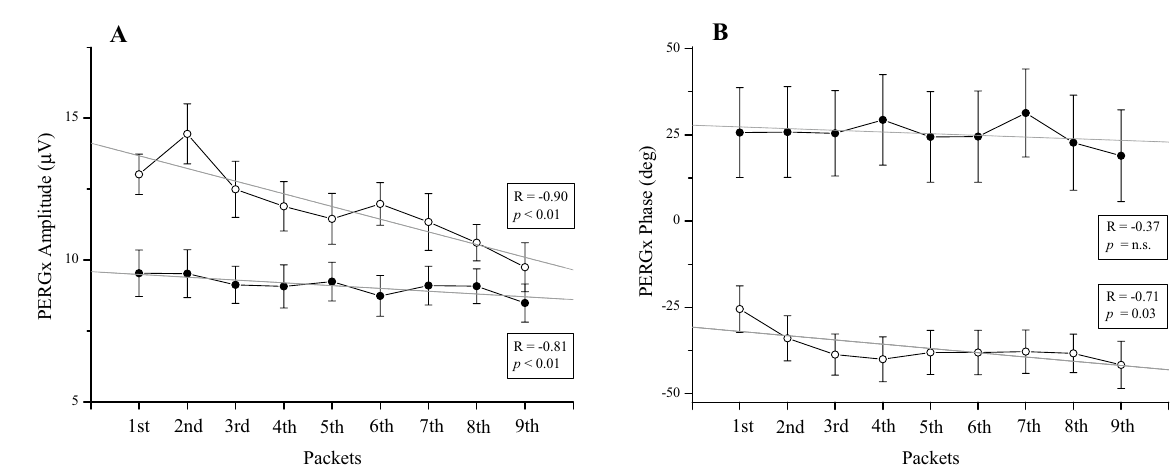
Figure 2. Scatter plots of scalar 2P amplitude ( A ) and phase ( B ) averaged across all subjects of both control (open circles) and patient (filled circles) groups as a function of packet number. The linear regression (R and p values are shown) applied to the amplitude and phase data shows a steeper decline (i.e. more negative slope) in controls compared with group. The slope of PERGx amplitude was significantly lower in absolute value (i.e. less negative) in patients compared to controls ( p < 0.01) (Fig. 3A). The PERGx phase angular dispersion was greater in patients but not significantly different between the two groups ( p = n.s.) (Fig. 3B). Both PERGx grand-average vector amplitude (Fig. 3C) and phase (Fig. 3D) were significantly different between the study groups ( p < 0.01), with the former measure being lower and the latter one less negative in patients compared to controls. As for the secondary morphometric measurements, the patient group revealed lower average RNFL and GCIPL thicknesses compared to controls, reaching the statistical significance ( p < 0.05) only in RNFL values. ROC curves were calculated for PERGx amplitude slope, grand-average vector amplitude and phase, and phase angular dispersion of patients and controls. The AUCs of PERGx amplitude parameters (Fig. 4A) were 0.87 (standard error [SE], 0.06; asymptotic p < 0.01; confidence limits, 0.76–0.98) for the amplitude slope and 0.76 (SE, 0.07; asymptotic p < 0.05; confidence limits, 0.62–0.90) for the grand-average vector amplitude. The